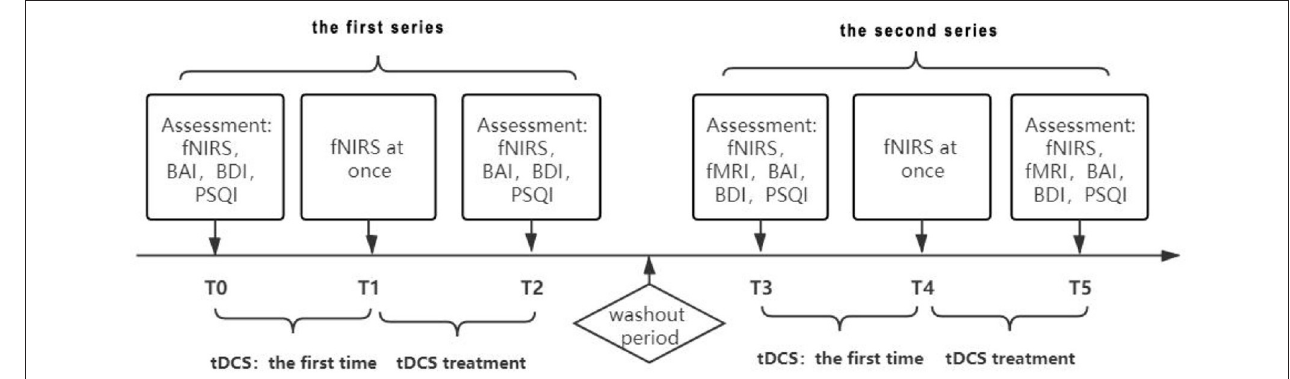
FIGURE 1 | The experimental